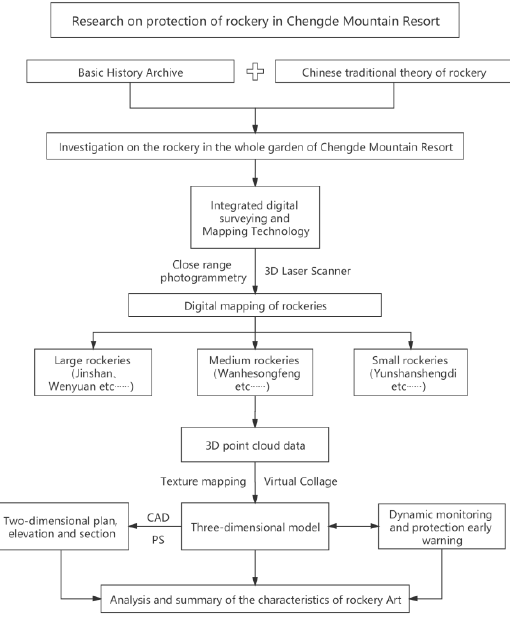
Figure 4 . Digital research framework of Mountain Resort rockery.(From Wang Yiru)